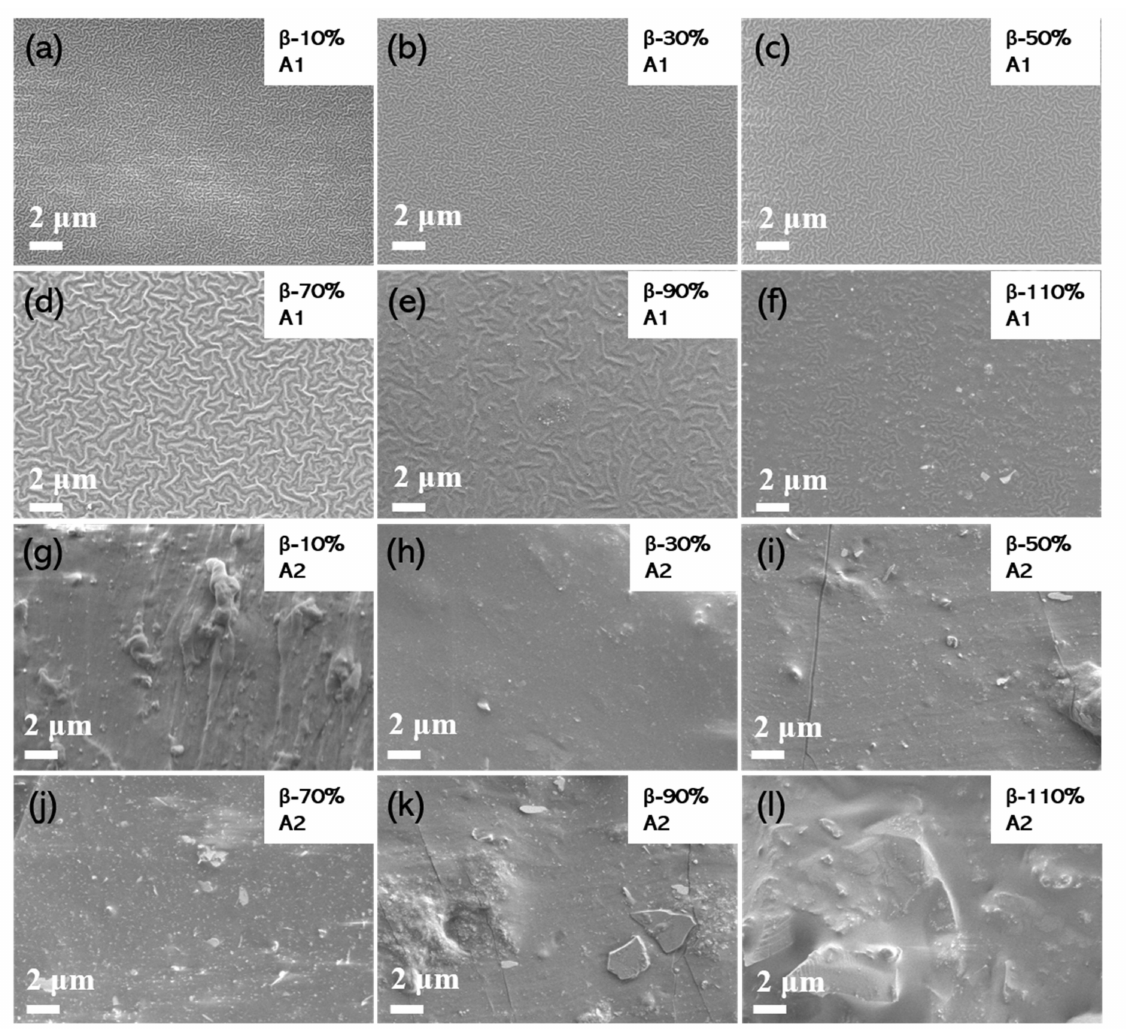
Figure 3. SEM images of polymer nanocomposite layers with different weight percentages. ( a – f ) The surface of polymer nanocomposite layers with different weight percentages. ( g – l ) The cross-section of polymer nanocomposite layers with different weight percentages. A1 and A2 mean the surface and cross-section of the layers,